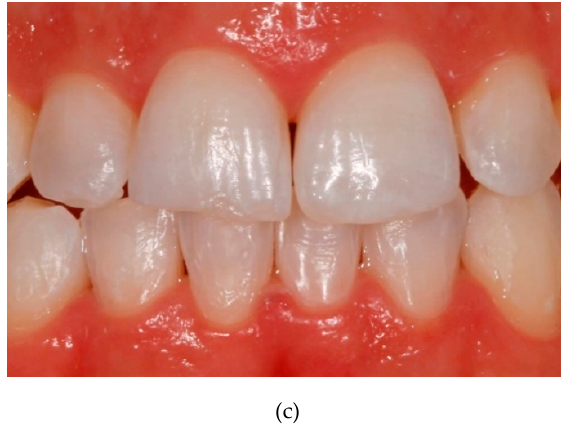
Figure 8. (a) Initial photograph of a Group 2S patient. (b) Photograph of Group 2S patient at the end of the second in-office session. (c) Photograph of Group 2S patient at the end of home